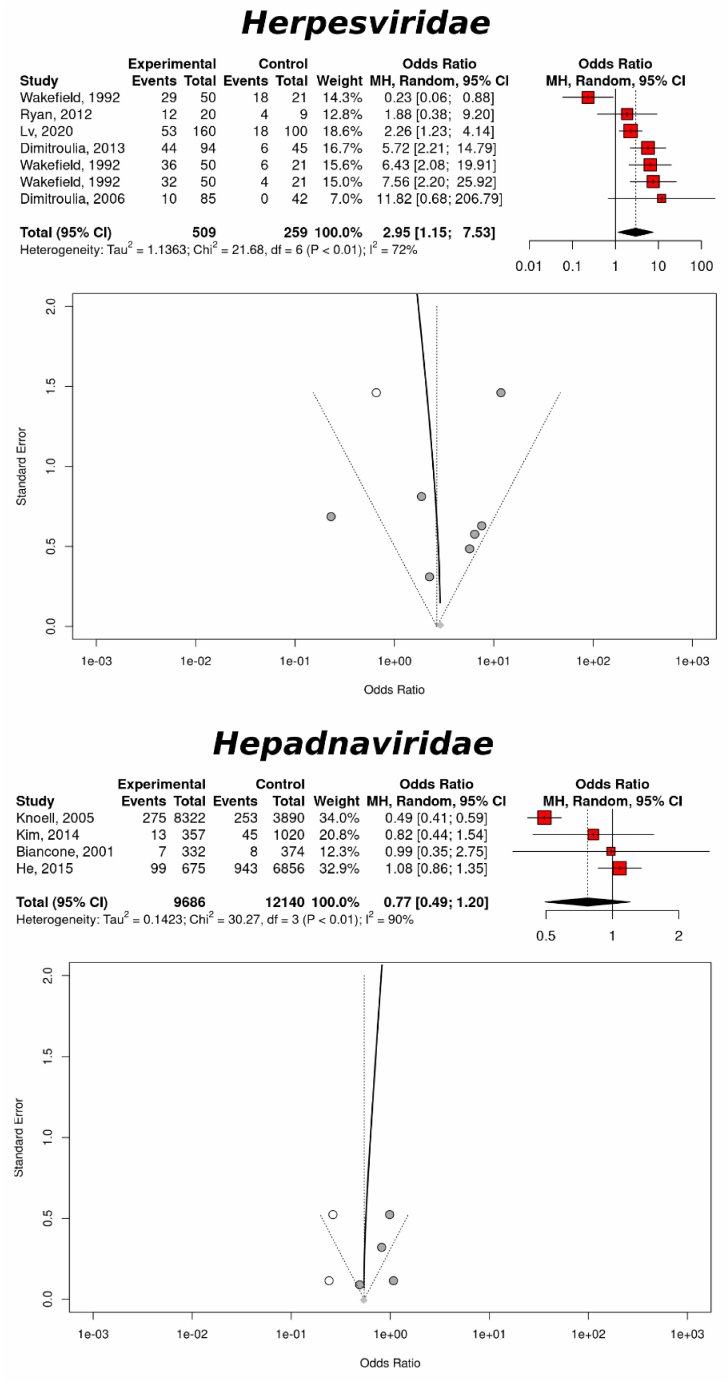
Figure 4. IBD risk and a viral infection. The upper panel refers to Herpesviruses, based on the gastric tissues, and the lower panel refers to Hepadnaviruses on the sera. Each panel includes a forest plot, based the random effects models and a funnel plot with a regression line. The studies added by the trim-and-fill method are represented by white